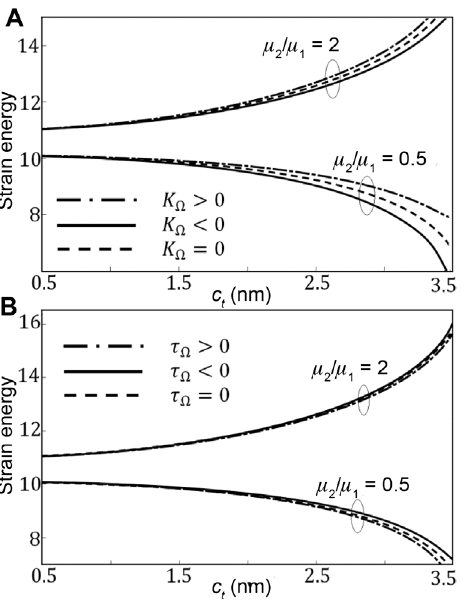
Figure 5 Dependence of the image force acting on a wedge disclination dipole on its position c = 0.5 and 2, ν = ν = 0.3, and = ν = 0.3, and (A) different values of K ν for a = 4 nm, μ / μ t 2 1 1 2 1 2 = 0, and (B) different values of τ = λ = 0. The image force values are given in units of at τ at values of τ at μ Ω Ω Ω Ω Ω Ω μ a 2 ω 2 /100. a ω 2 1 1